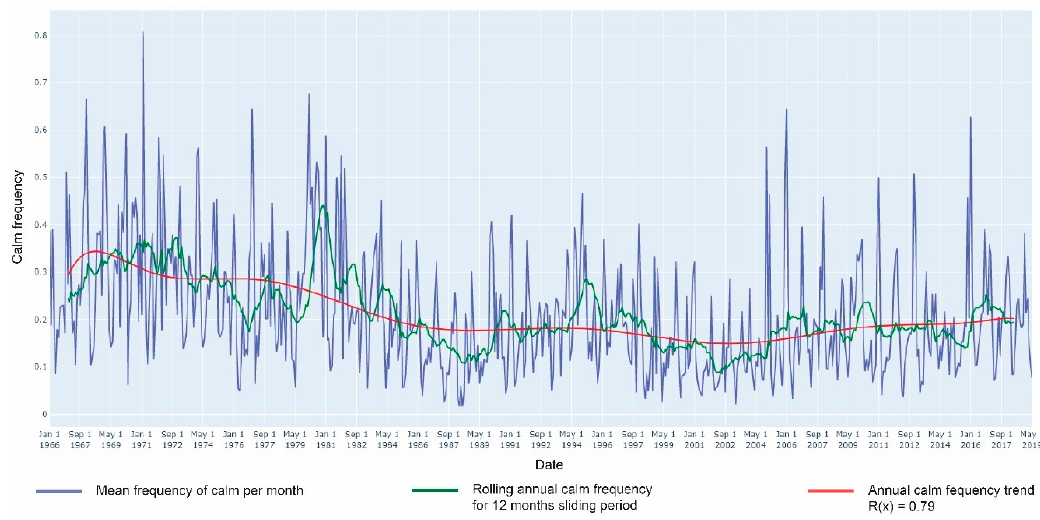
Figure 4. Calm frequency for the period from 1966 to 2019.